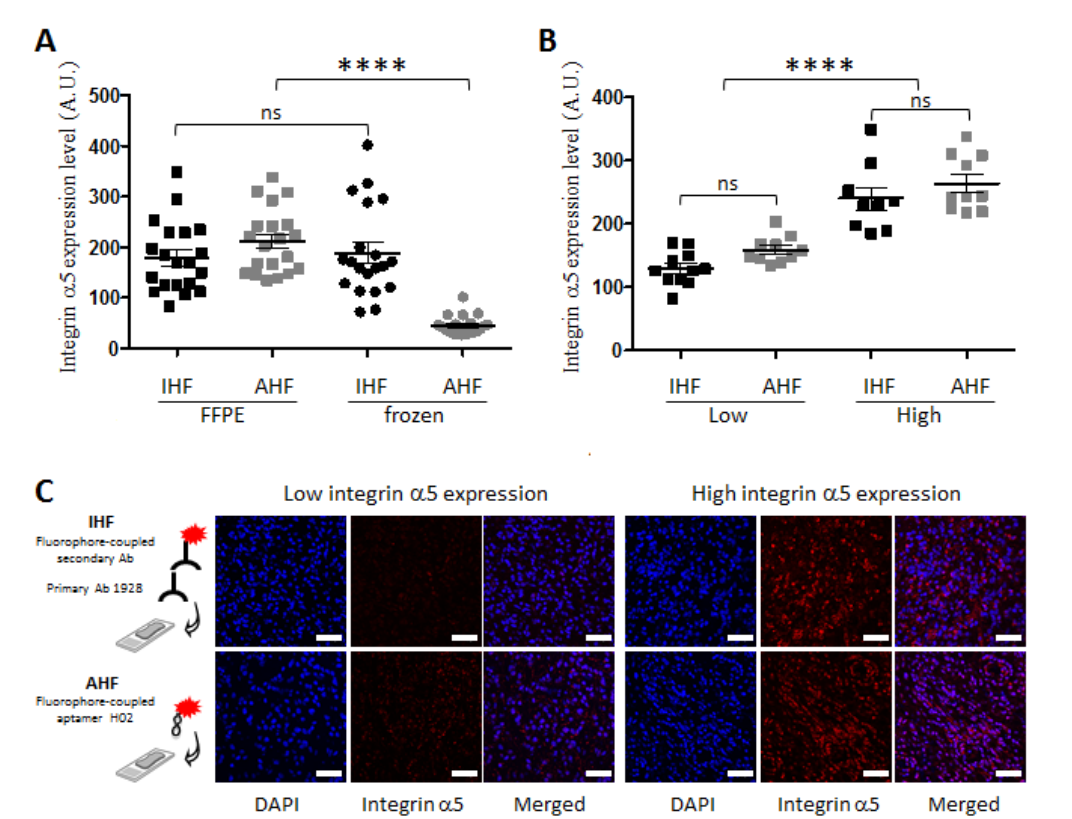
Figure 3. Quantification of integrin α5 expression level in 20 glioblastoma tissues using immuno- histofluorescence (IHF) and aptahistofluorescence (AHF). ( A , B ) Distribution of cumulative data obtained via IHF (black) and AHF (gray) ( A ) of formalin-fixed paraffin-embedded (FFPE; squares) and frozen (circles) sections and ( B ) of FFPE sections only, considering samples showing high or low integrin α5 expression levels expressed as arbitrary units (A.U.). Statistical analyses were performed with Student’s t test (**** p < 0.0001; ns, not significant). ( C ) Representative images of low and high integrin α 5 expression staining via IHF and AHF are represented (magnification × 40). The drawings on the left (not to scale) symbolize the detection in tumor sections using IHF (as an indirect method of detection, with Ab 1928 and a fluorophore-conjugated secondary antibody) and AHF (as a direct detection method, with fluorophore-coupled aptamer H02). Integrin α 5 labeling is represented in red. Nuclei were stained with DAPI (blue). Scale bar = 50 µm.